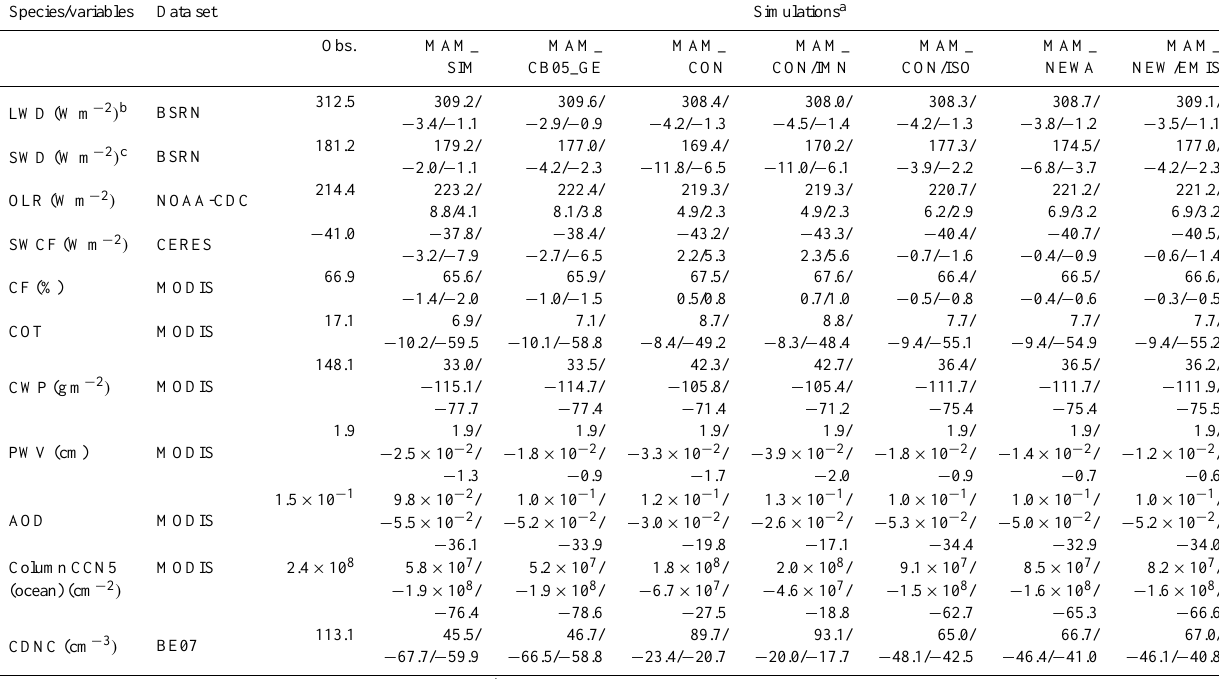
Table 2. Mean bias (MB) and normalized mean bias (NMB, in %) of radiative/cloud predictions for the 2001 simulations. Species/variables Data